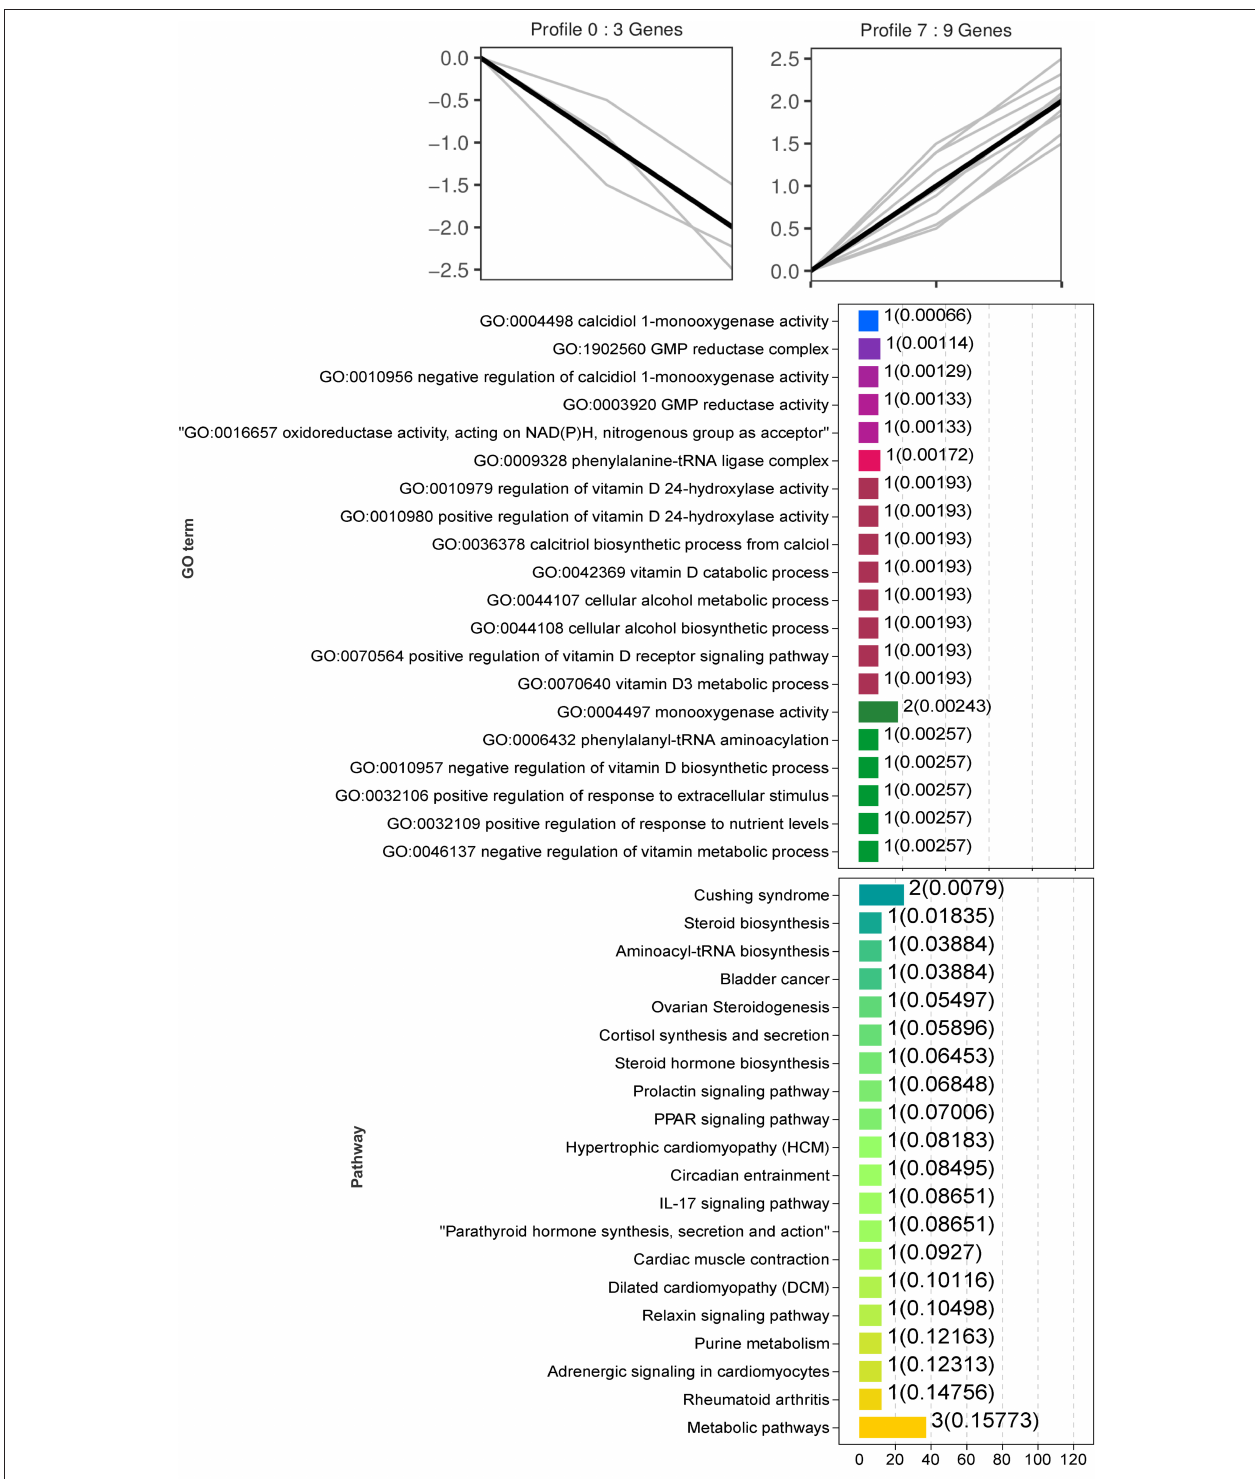
FIGURE 7 | GO and KEGG enrichment analysis of the ST responding DEGs (in profile 0 and profile 7) with increasing BHBA concentrations.